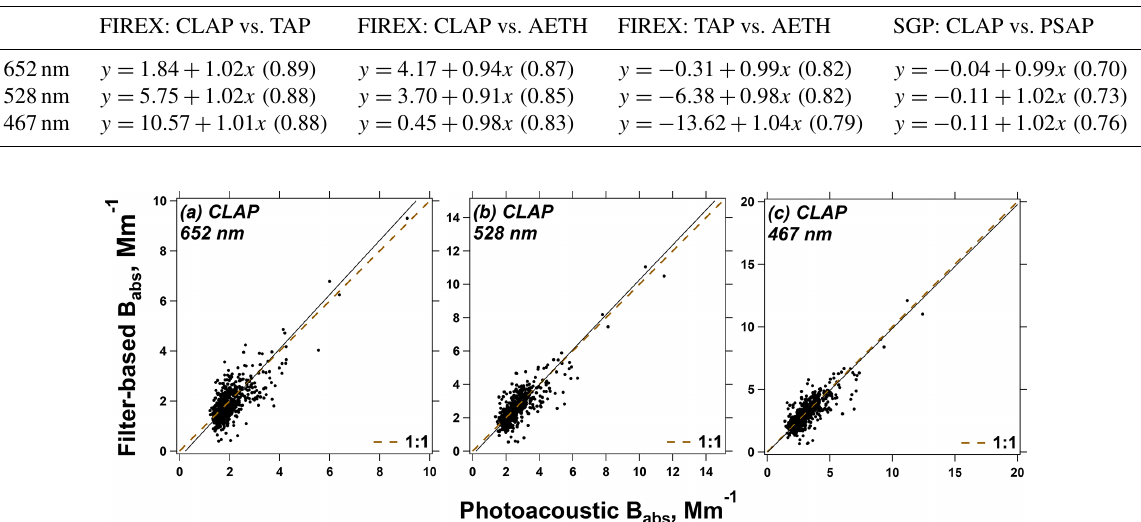
Table 6. Intercomparison between different filter-based B abs corrected by Algorithm A in the present work. The value in the parentheses rep- resents the coefficient of determination ( R 2 ) of the linear relationship.